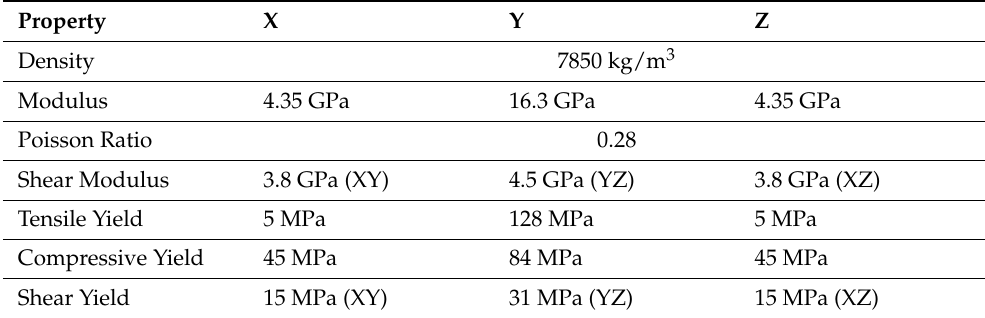
Table 2. Material data input into ANSYS corresponding to the geometry